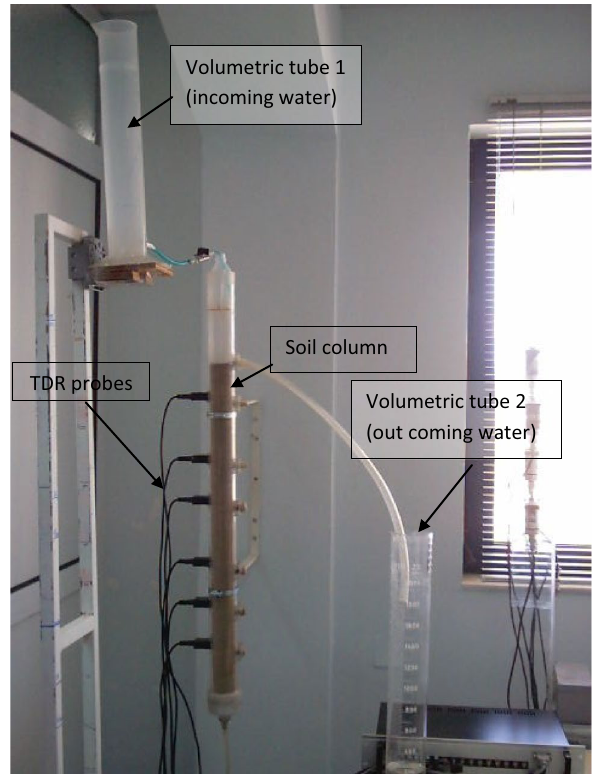
Fig. 1 Experimental